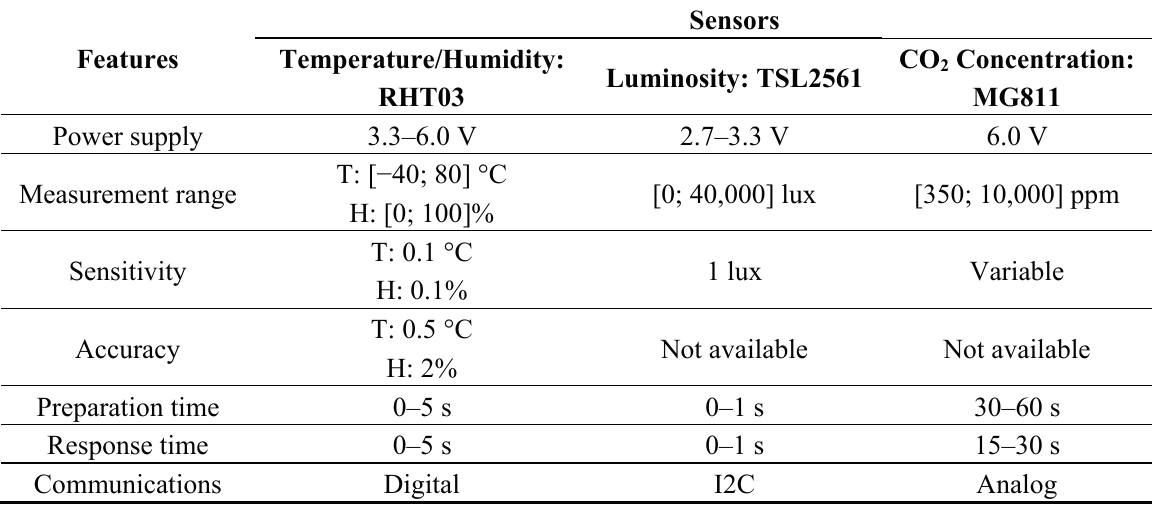
Table 2. Sensor features. Source: Sensor